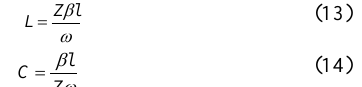
Figure 3. RF MEMS capacitive shunt MEMS. It consists of high resistivity (HR) silicon, Au CPW, SiN dielectric, anchor and folded beam. (a) Top view of the switch. L and w are the length and width of beam. (b) Cross section view of the switch.